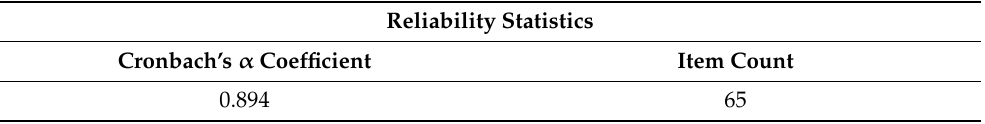
Table 2. Cronbach’s α coefficient from survey